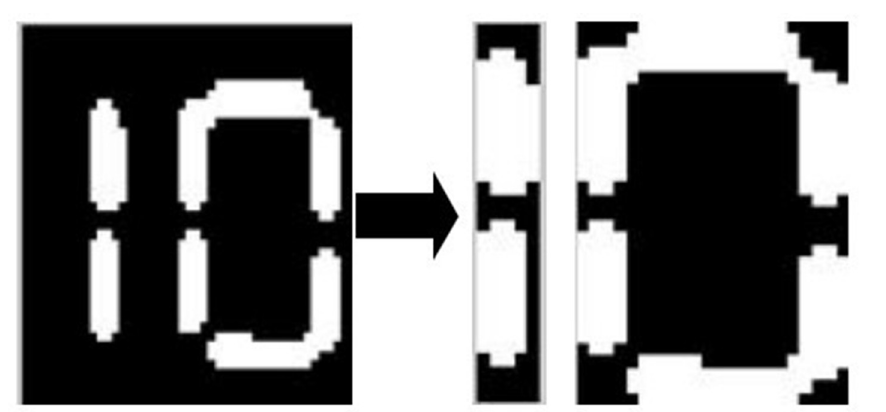
Fig 8. The image segmentation based on the projection